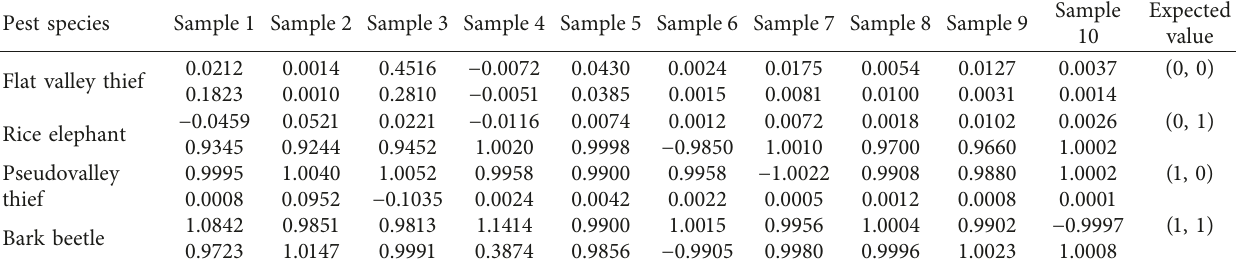
Table 1: Output of simulation experiment